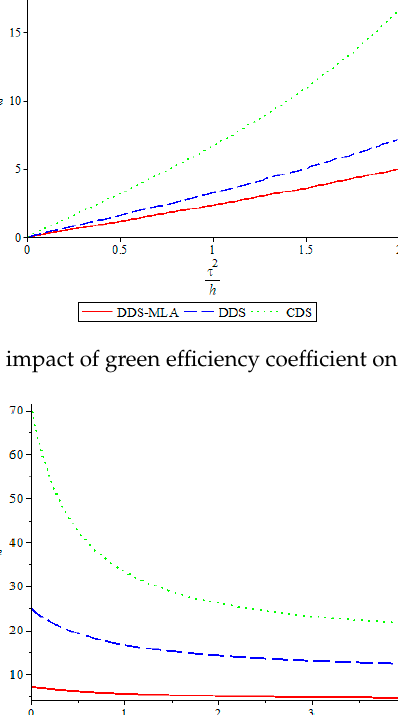
Figure 8. The impact of green efficiency coefficient on profit of green supply chain.